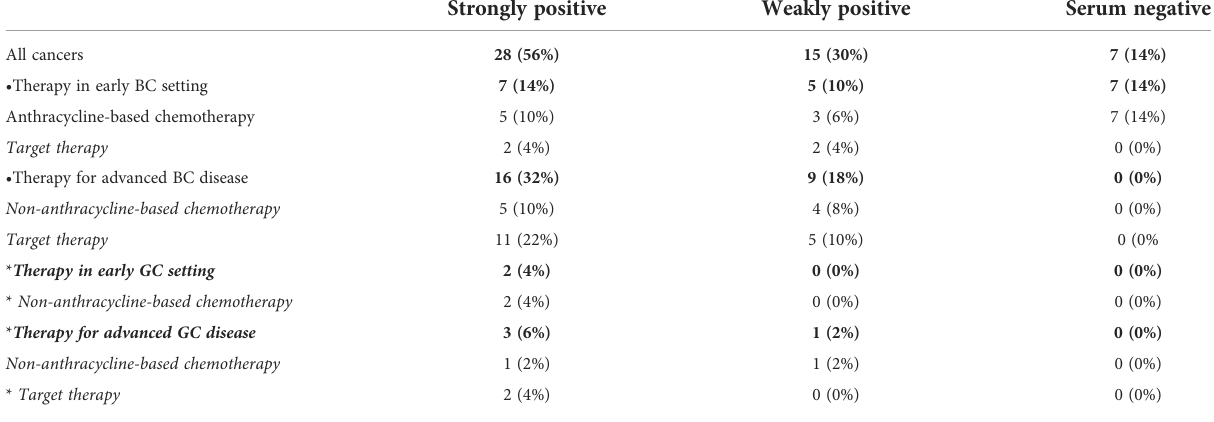
TABLE 4 SARS-CoV-2 neutralizing antibody titers according to anticancer therapy. Strongly positive Weakly positive Serum negative 28